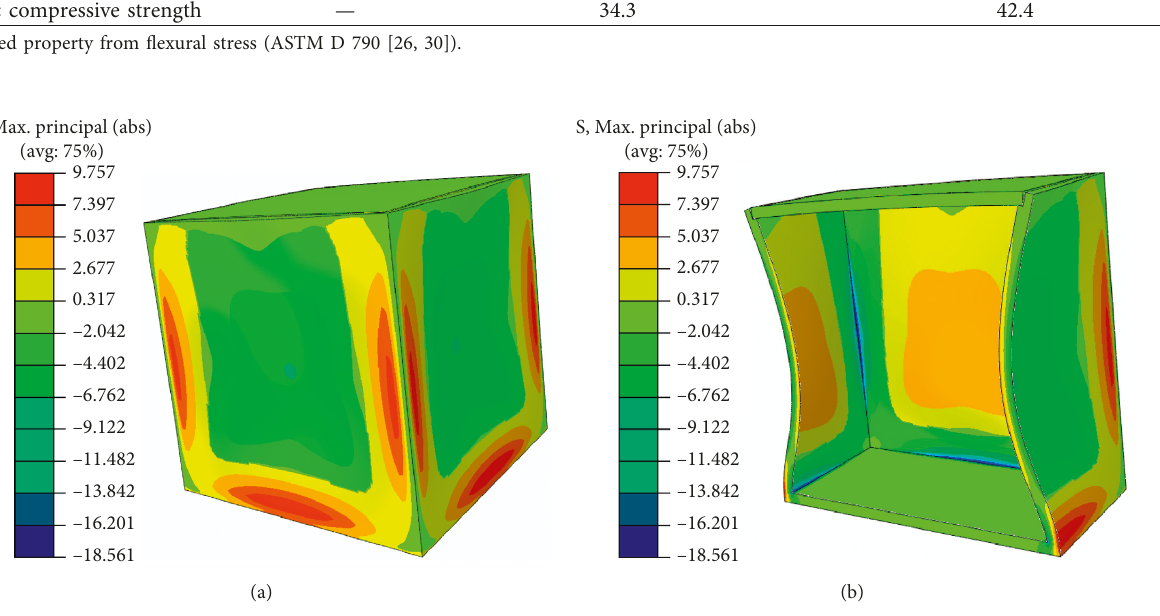
Figure 8: (a) Tensile (positive) and (b) compressive (negative) stress results for Utility Structure 1 with a wall thickness of 25mm with a lateral pressure of adjacent soil of 82kPa.